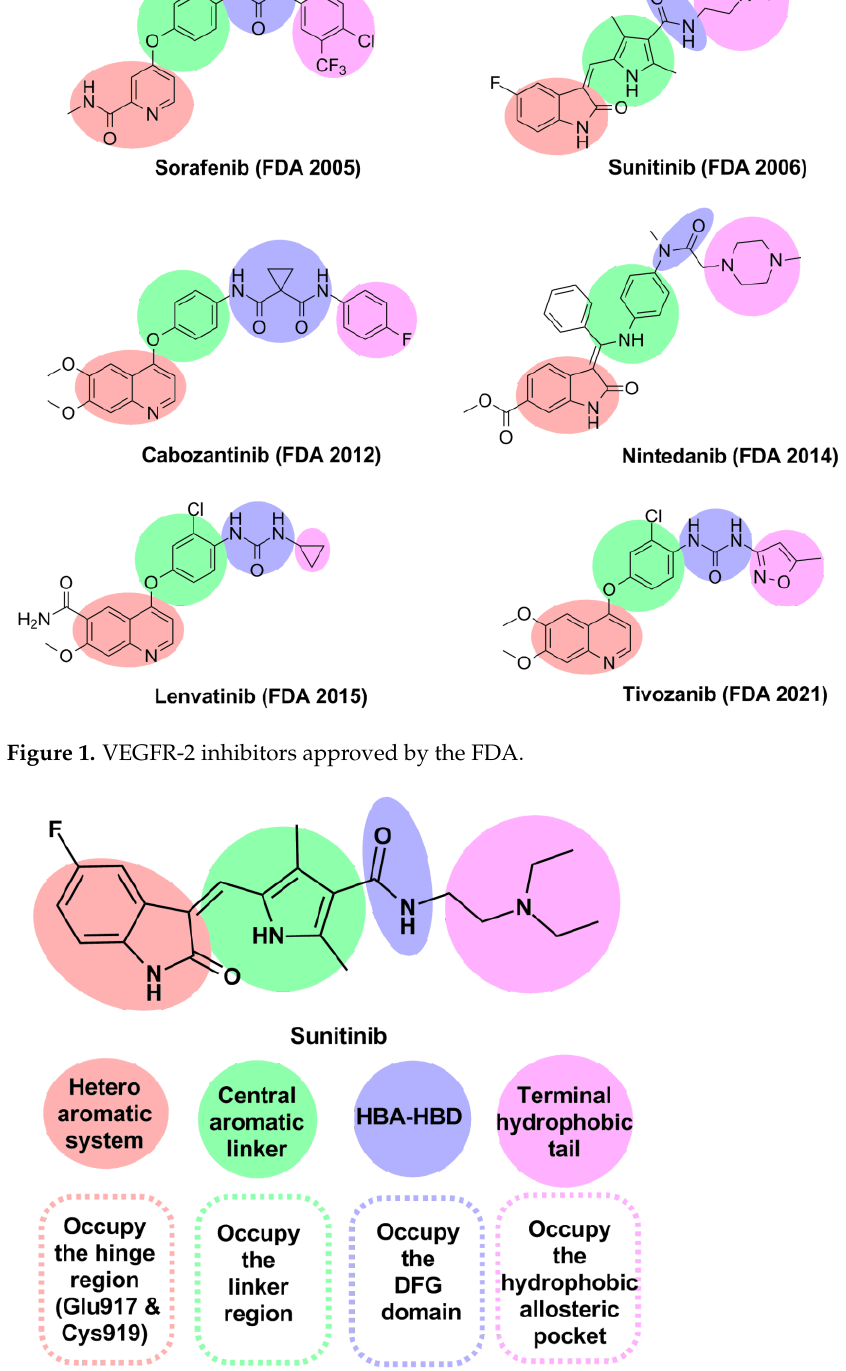
Figure 2. The essential pharmacophoric features of VEGFR-2 inhibitors applied to sunitinib.